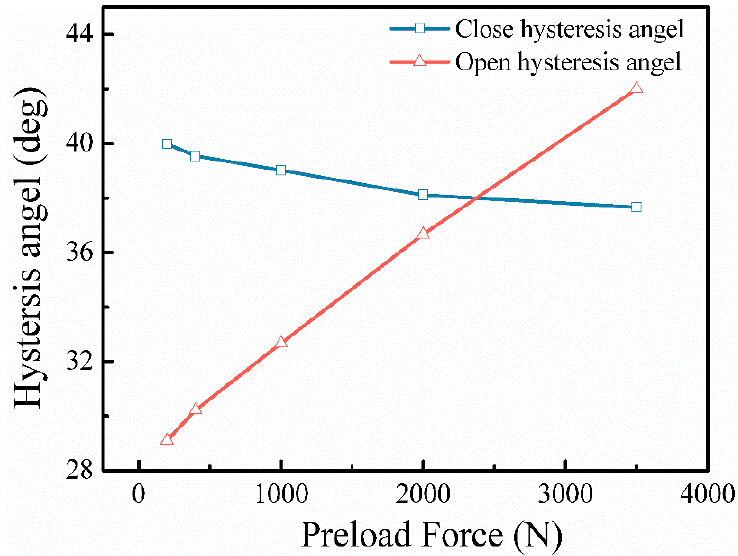
Figure 13. Effect of discharge valve preload on hysteresis angle.